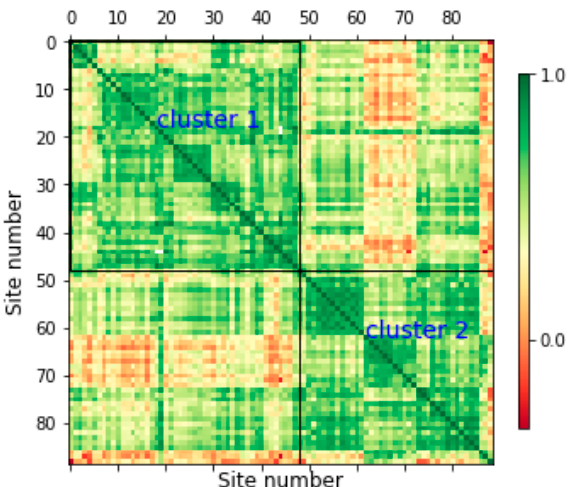
Figure 4. Correlation heat map of all the sites in groups. The sites were numbered from 0 to 88. Cluster 1 includes number 0 to number 47, while cluster 2 includes number 48 to number 88.